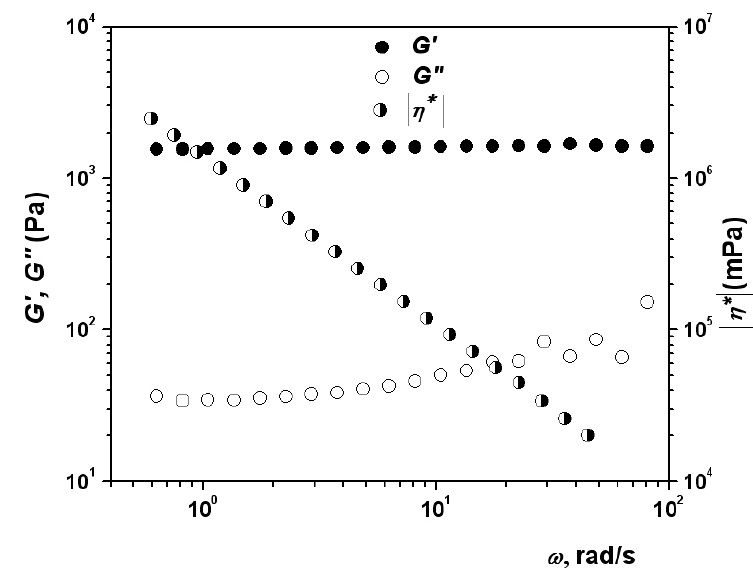
Figure 6. Angular frequency dependence of G’, G’’ and | η *| for PAAm/Dx semi-IPN gels prepared at -18 o